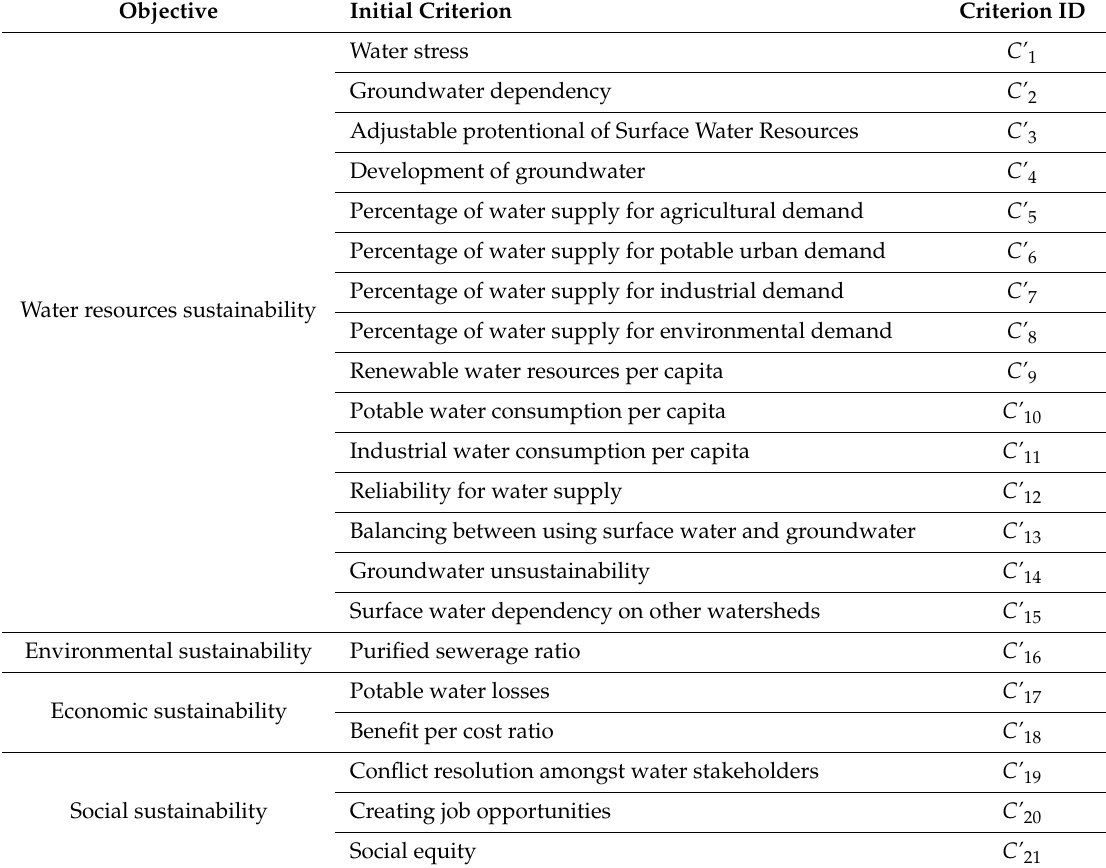
Table 4. The initial sustainable development criteria for the Kashafroud watershed